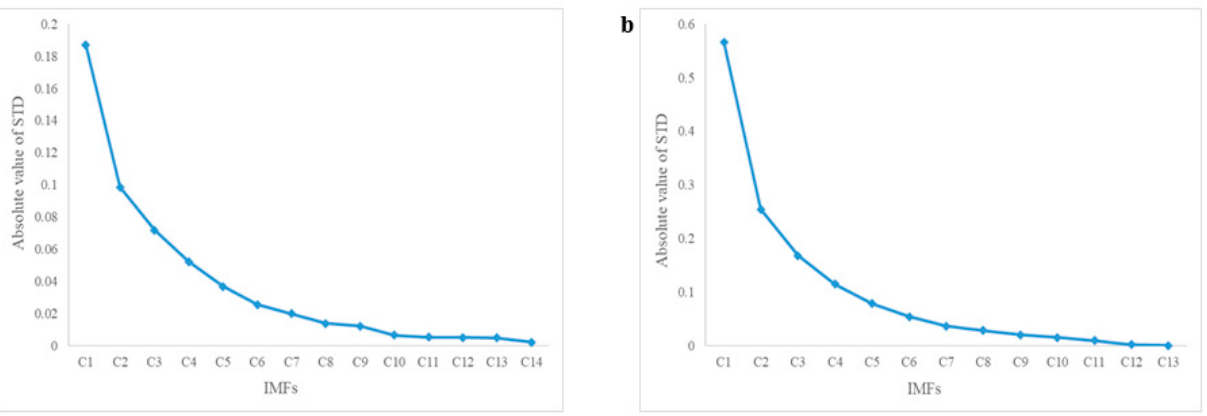
Figure 8. The change in the STD value of the data during EEMD processing. ( a ) at the same site; ( b ) at two different sites.